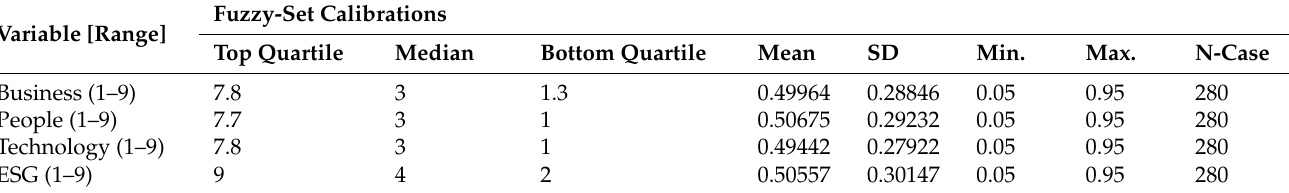
Table 1. Calibrations and Descriptive Statistics of the Research Variables.